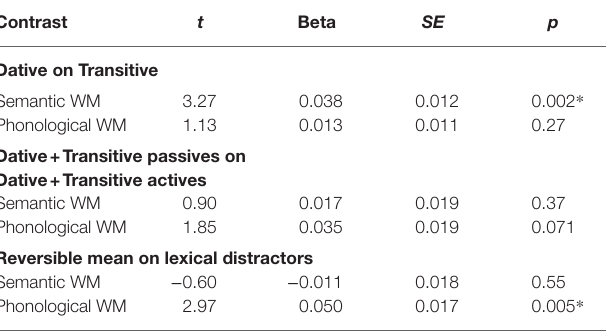
TABLE 6 | Coefficients and significance levels for the independent contributions of semantic and phonological WM to active-passive sentence